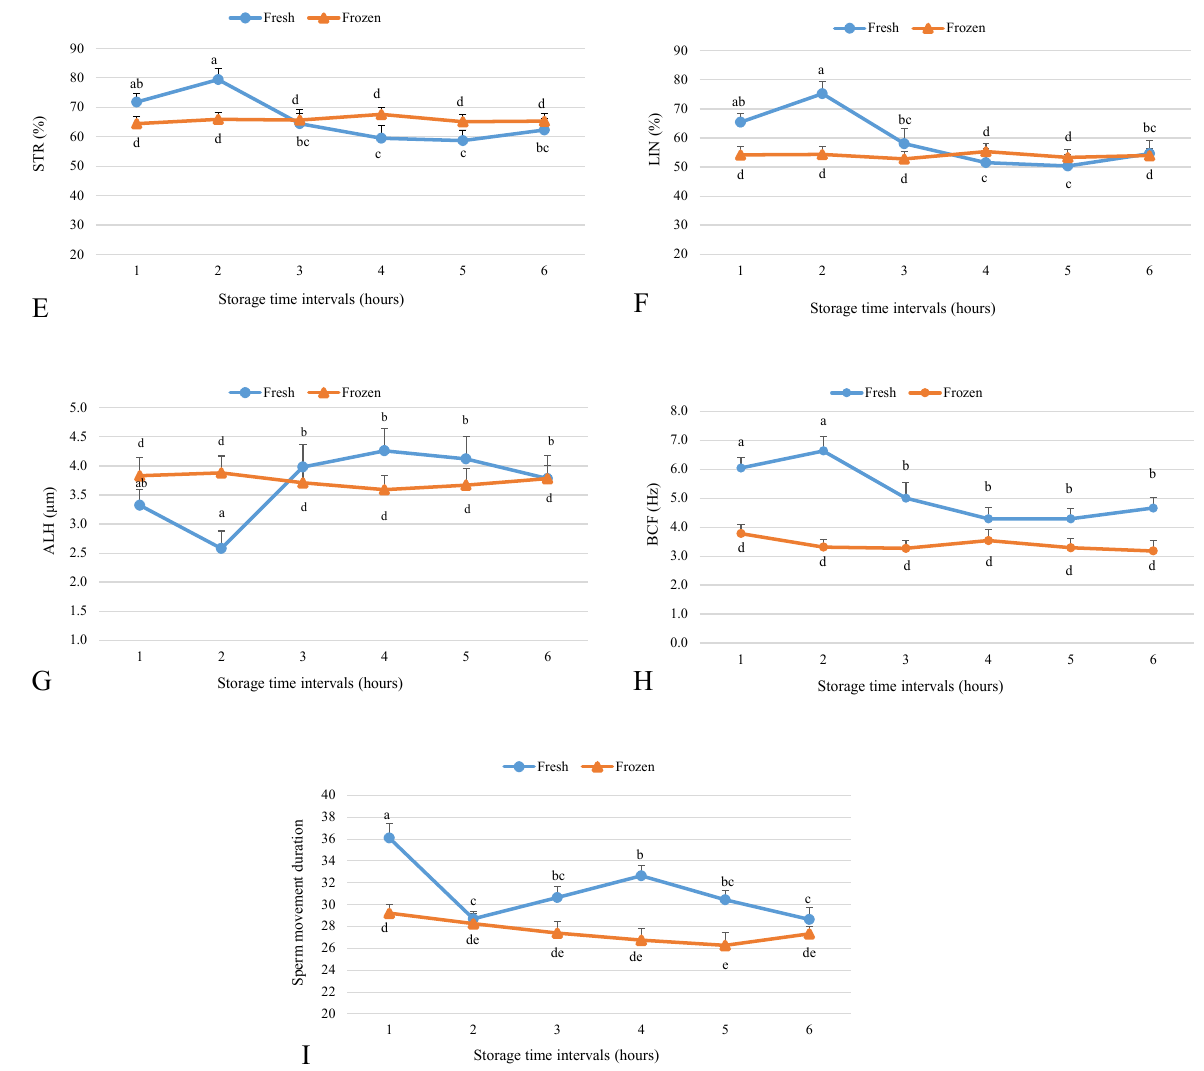
Figure 1. Effect of storage time post-collection on fresh and frozen sperm motility parameters ( A – I ). Total motility: the percentage of motile spermatozoa; VCL: curvilinear velocity; VSL: straight-line velocity; VAP: average path velocity; LIN: linearity (VSL/VCL × 100); STR: straightness (VSL/VAP × 100); BCF: beat cross frequency; ALH: amplitude of lateral displacement of the spermatozoon head. a,b,c Different superscript letters within the time intervals of fresh semen are statistically different ( p < 0.05). d,e Different superscript letters within the time intervals of frozen semen are statistically different ( p < 0.05).